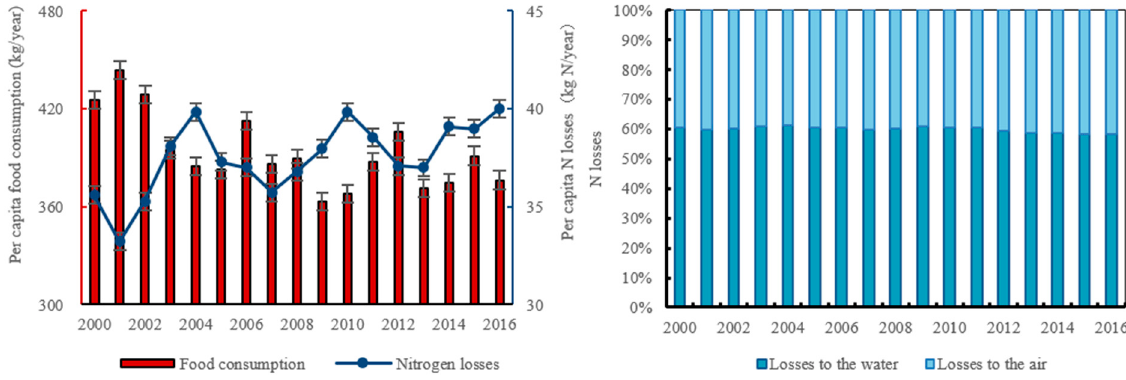
Figure 5. Variation of food consumption and N losses from 2000 to 2016.